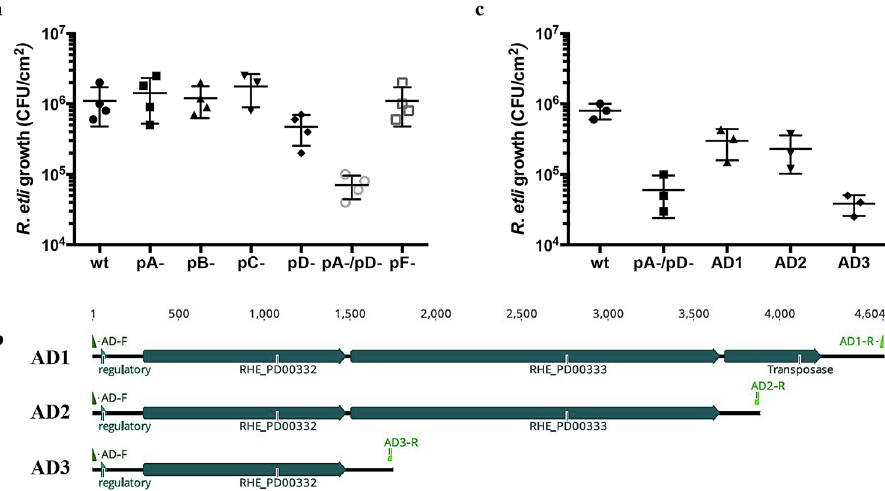
Figure 3. Plasmids pA and pD encode proteins performing functions that are necessary for the coexistence of bacterial cells with yeast. Growth of R. etli strains in biofilms with S. cerevisiae S1278B. ( a ) Growth in mixed biofilms of R. etli strains lacking the plasmids; pA, pB, pC, pF and in one case of two plasmids, pA-/pD-. The growth of the rhizobia strains was assessed at 24 h. ( b ) Scheme of the genes contained in a cosmid that partially complements the growth of the pA-/pD- strain in mixed biofilms. Here, 3, 2 and only one gene was amplified to generate the plasmids AD1, AD2 and AD3, respectively, as indicated in the figure. ( c ) Growth of R. etli strains in mixed biofilms. Strains AD1 and AD2 are R. etli pA-/pD- cells that carried plasmids AD1 and AD2, respectively. The growth of rhizobium strains in mixed biofilms was estimated at 24 h. The data are representative of 3 independent experiments +/− the S.D.